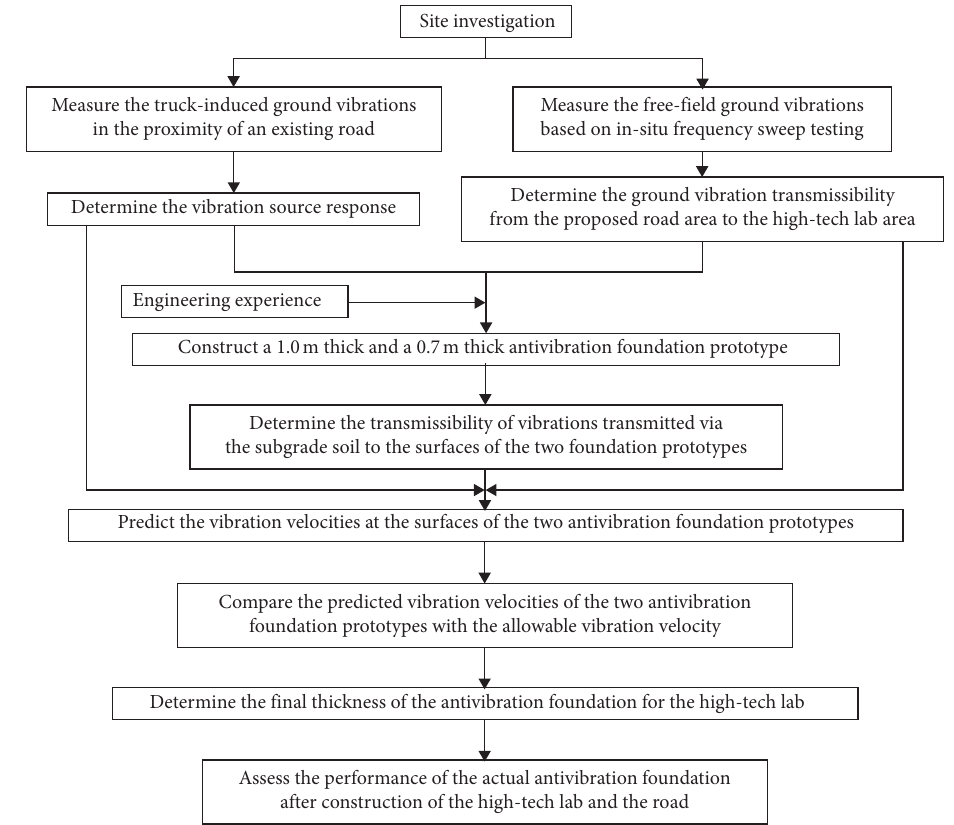
Figure 1: Flowchart of the design process of the antivibration foundation.